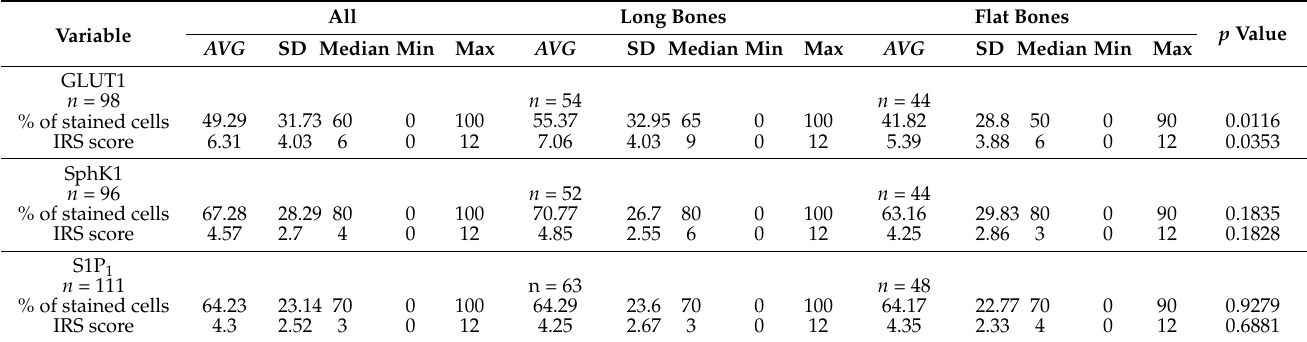
Table 3. Immunohistochemical results for GLUT-1, SphK1 and S1P 1 .